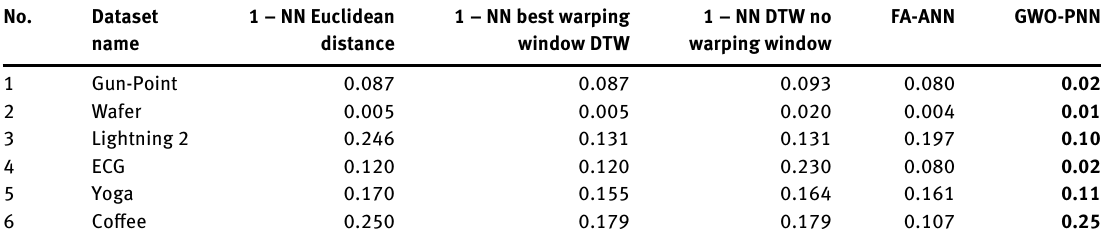
Table 5: A Comparison of the Results by GWO-PNN and Other State-of-the-Art Methodologies for Error Rate. No. Dataset